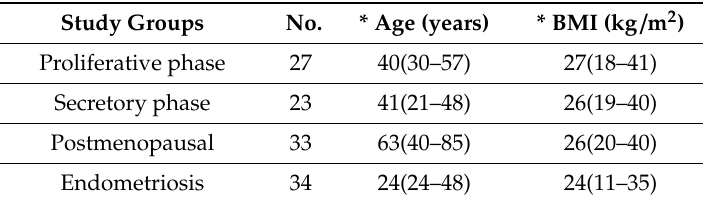
Table 1. Demographic features of study